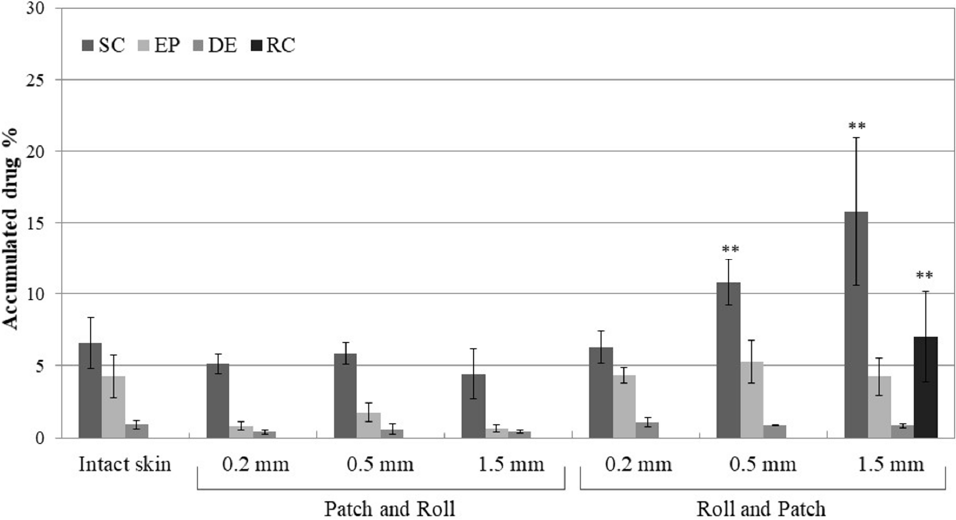
the dose applied on the skin. Patch and Roll: nanosuspension applied before microneedling. Roll and Patch: nanosuspension applied after microneedling. SC, stratum corneum; EP, epidermis; DE, dermis; RC, receptor compartment. ** p < 0.01 vs. Intact skin. RC, receptor compartment. ** p < 0.01 vs. Intact